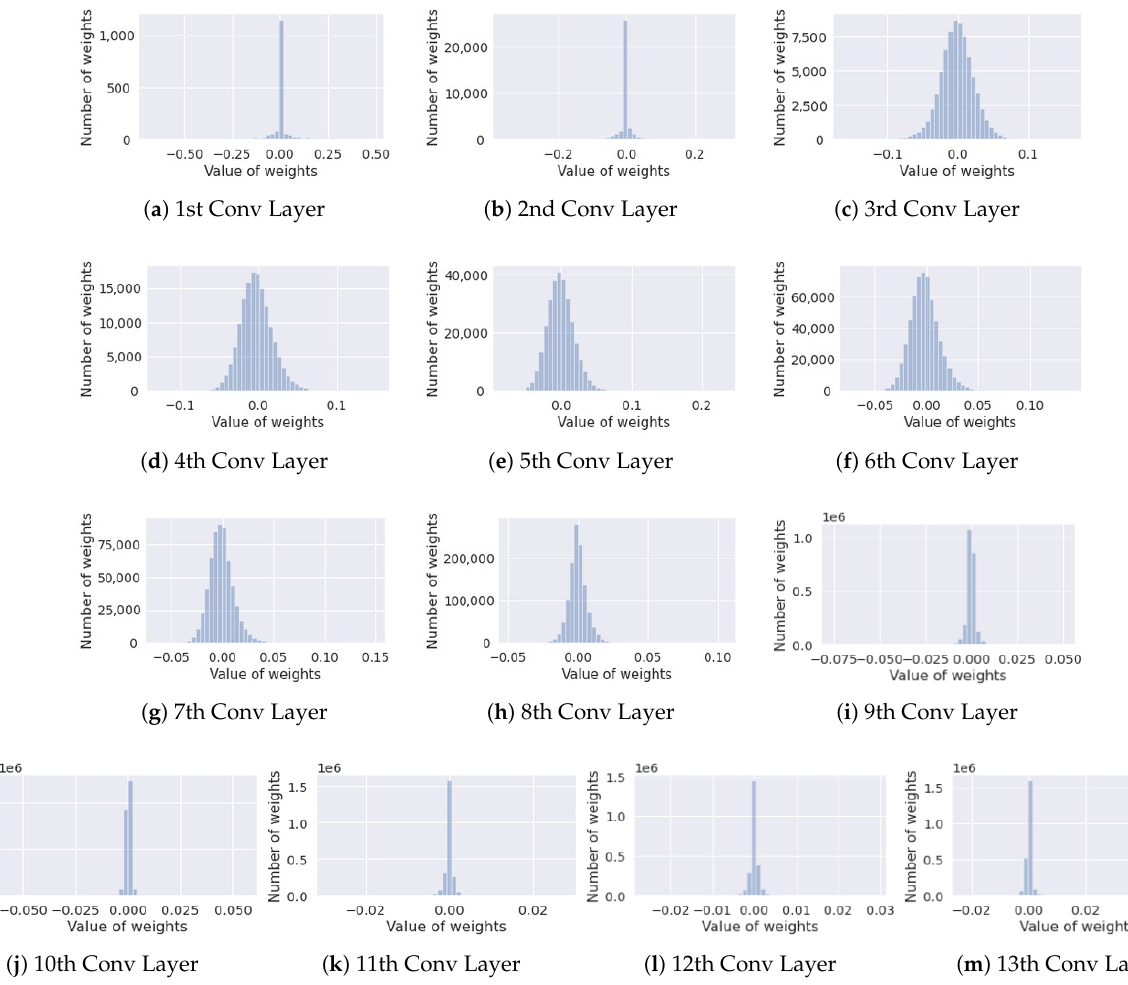
Figure 2. The distribution of weight parameters in each layer of a pre-trained model